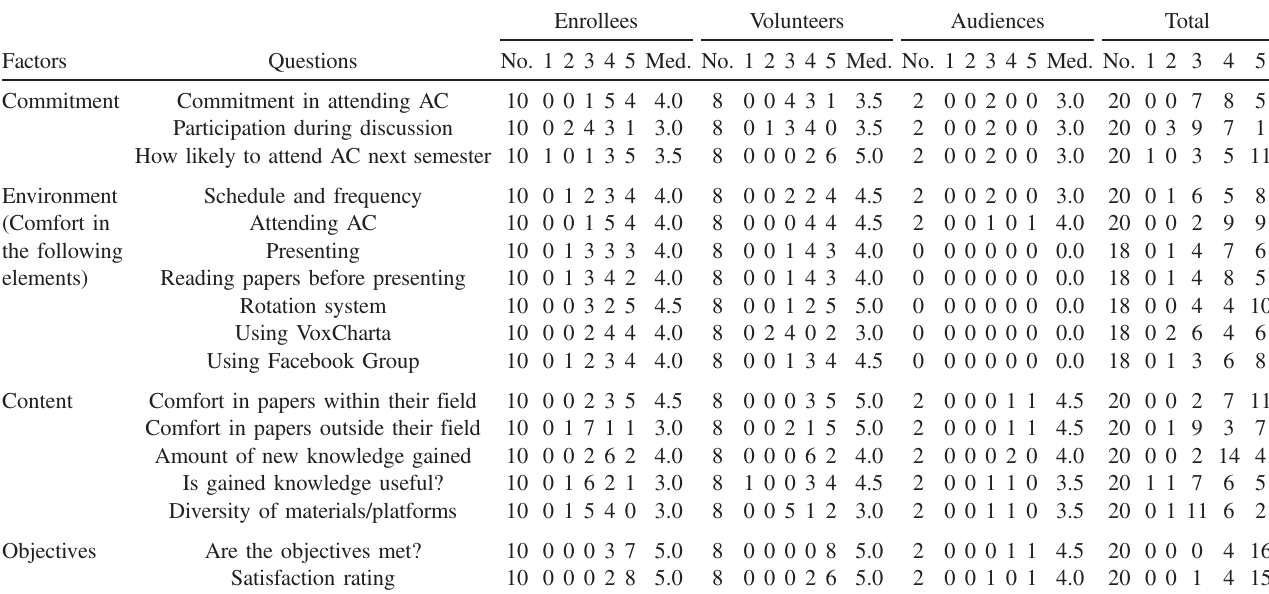
TABLE IV. Frequency distribution of Likert-scale questionnaire results. The number of respondents per group (No.) and median (Med.) are reported as well.